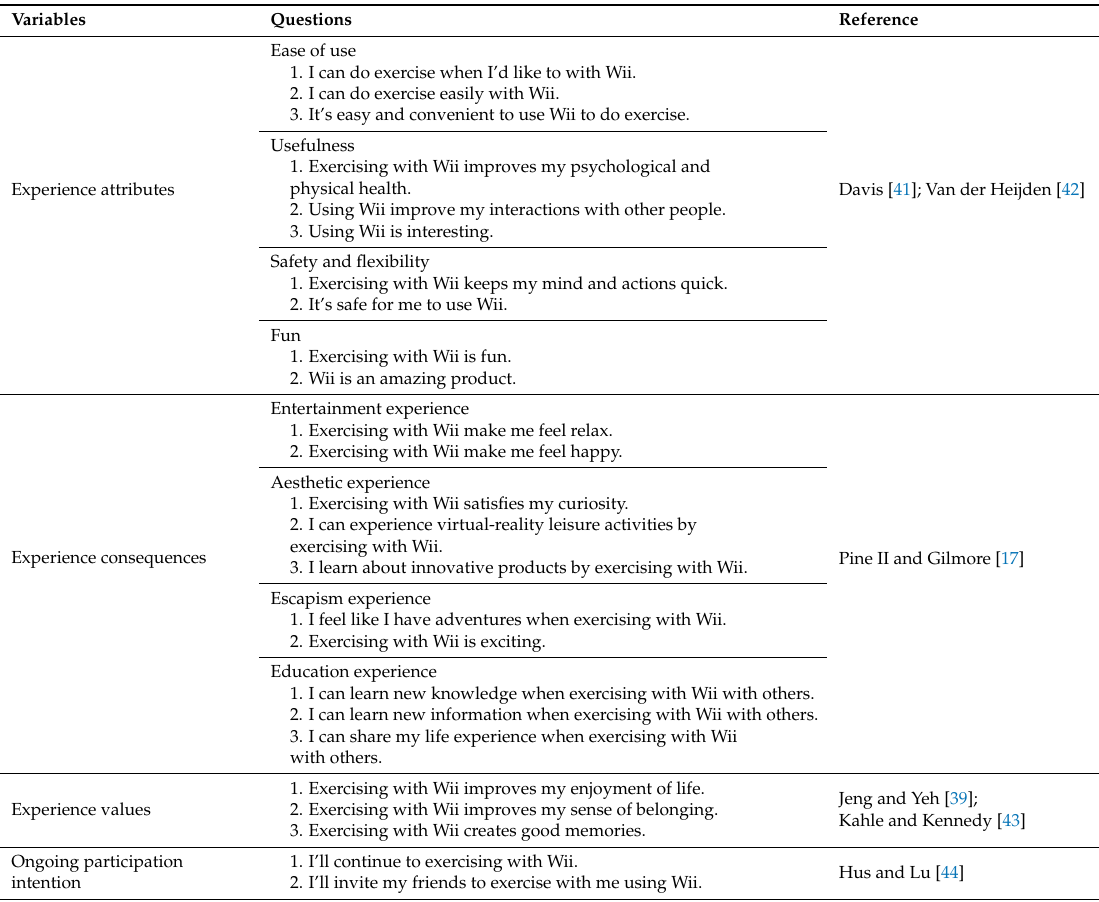
Table A1. Variable